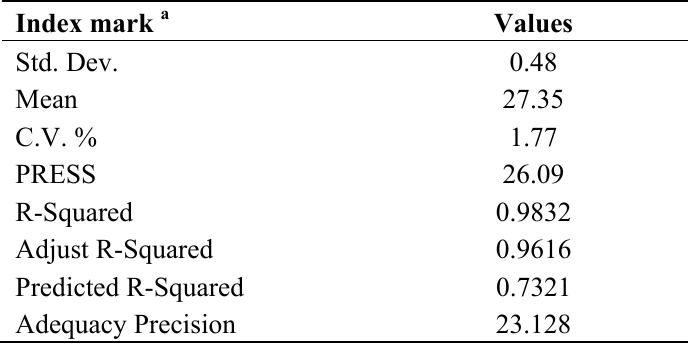
Table 3. Credibility analysis of the regression equations.